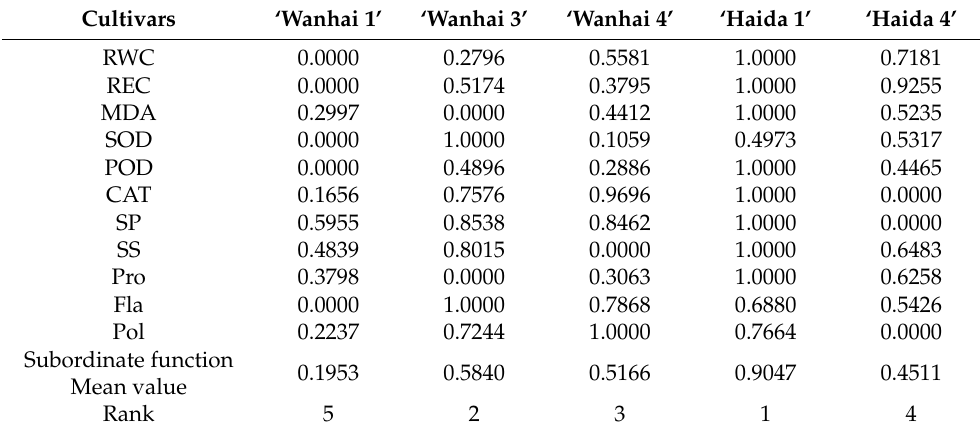
Table 1. Membership function values of 5 C. vietnamensis